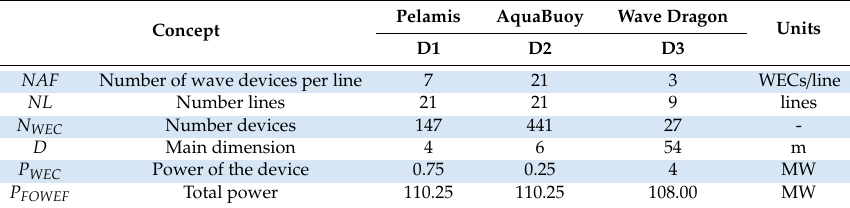
Figure 5. Types of devices studied: Pelamis (1) [62], AquaBuoy (2) [63] and Wave Dragon (3) [64].